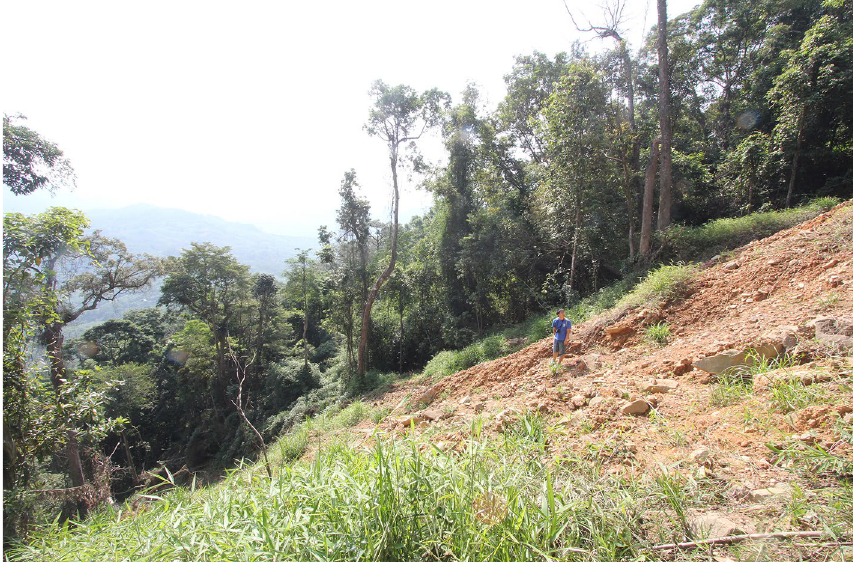
Figure 2. Forest gap of the canopy bridge site 10 months after Typhoon Rammasun, taken on 4 May 2015. Photograph taken by